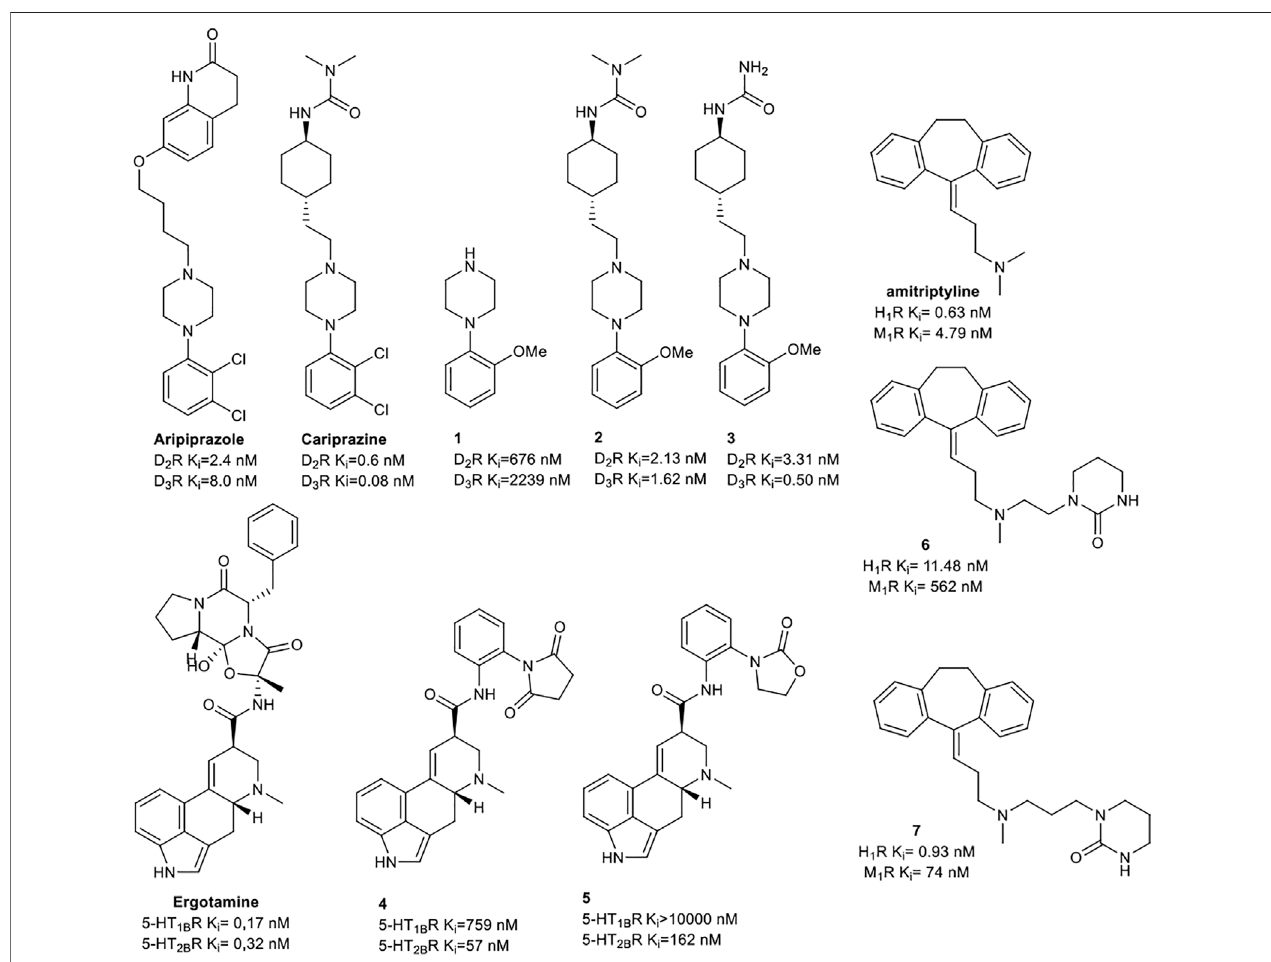
FIGURE 5 | Designed bitopic ligands and the reference compounds in the study of Keser ű et al. (Egyed et al., 2021).